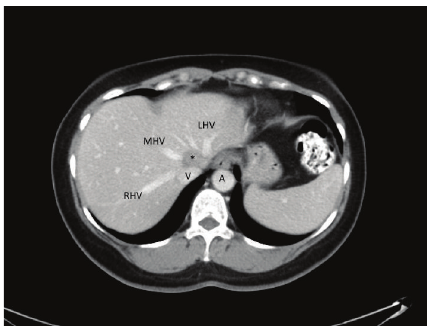
Figure 3: Coronal CT images marked with yellow arrows that point to the area of involvement of the retrohepatic IVC at the superior border of the liver. This area corresponds to the metastatic deposit on the axial images in Figure